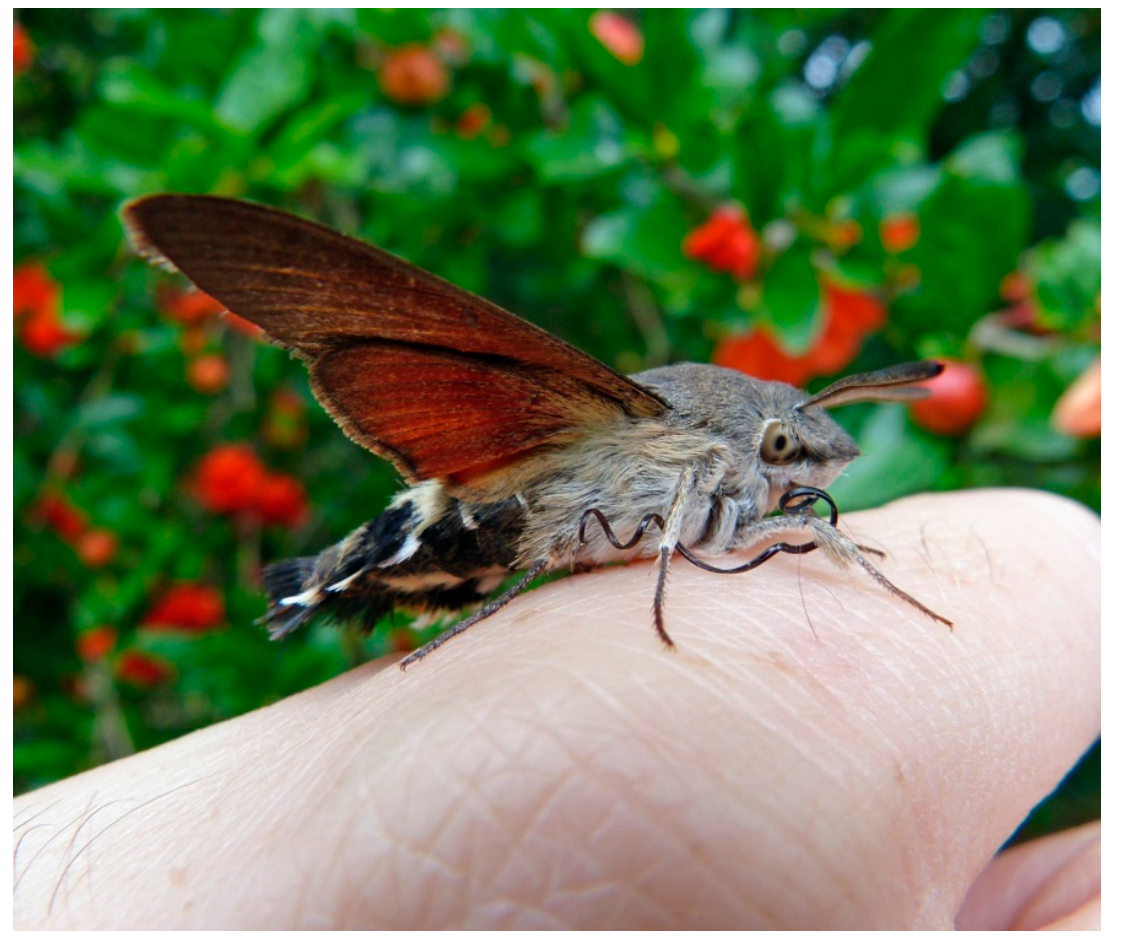
Figure 4. An exhausted specimen of Macroglossum stellatarum that was stuck in the flower of Oenothera speciosa for several hours. The proboscis was unrolled and clearly damaged even though the moths were set free. Photo credit: Andrea Bonifazi.